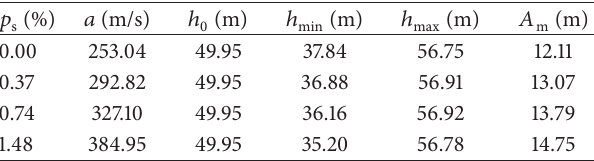
Table 3: Extreme pressure with various reinforcement ratios (vis- coelastic